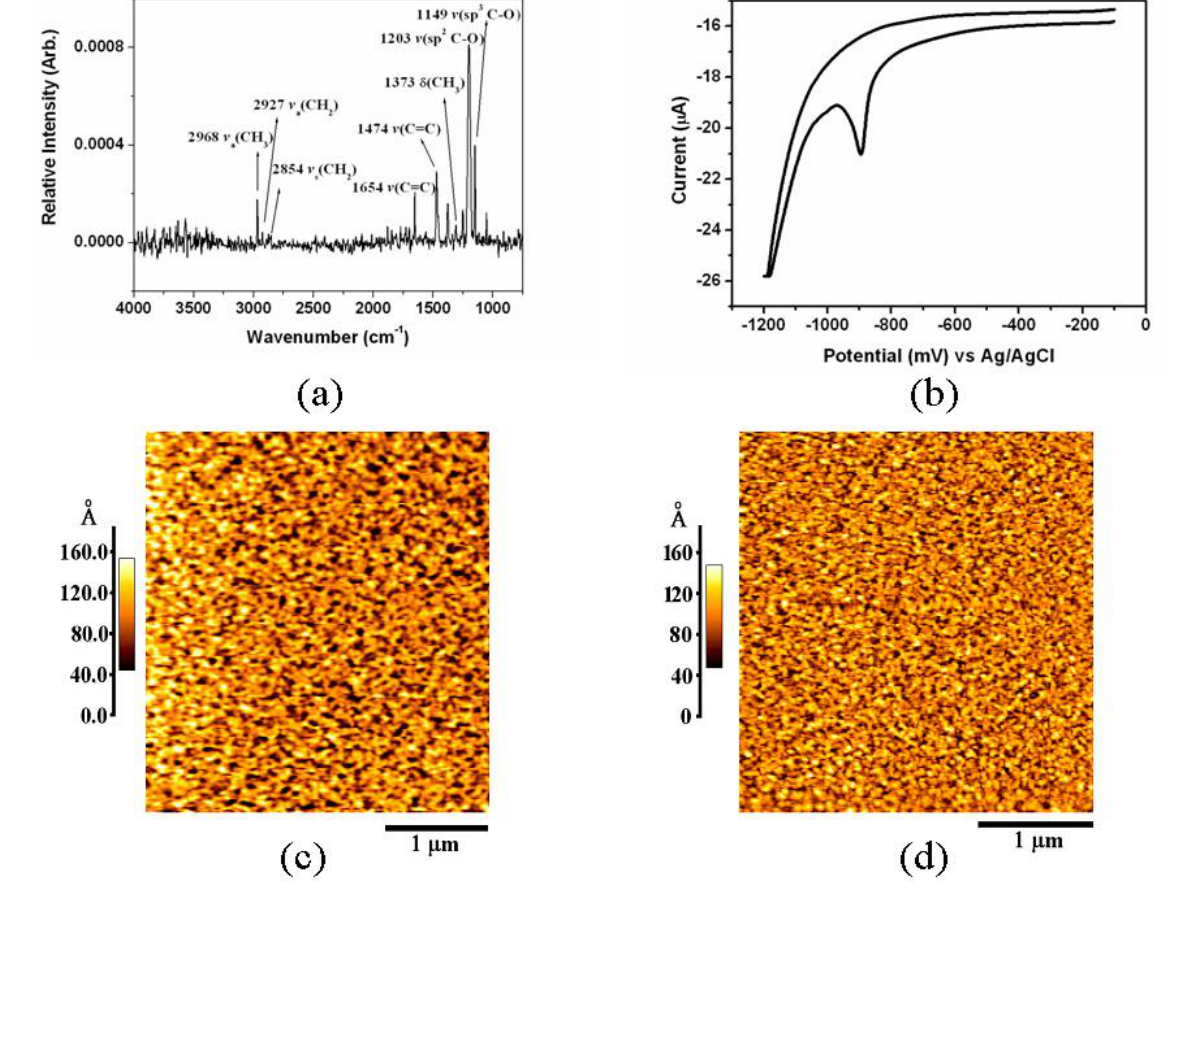
Figure 2. Characterization of the calix[4]crown SAM: ( A ) FTIR-RAS spectrum; ( B ) CV for reduction of the calix[4]crown on the gold electrode in 0.5 M KOH; and AFM image of ( C ) bare gold; and ( D ) the calix[4]crown SAM on